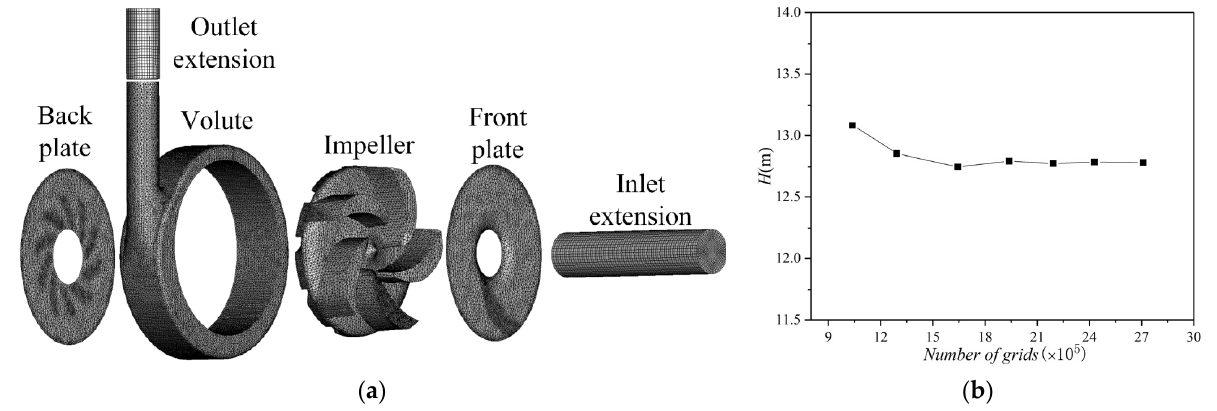
Figure 3. Meshing and independence verification: ( a ) Geometry and mesh. ( b ) Mesh independence. Table 1. Main design parameters of centrifugal pump.